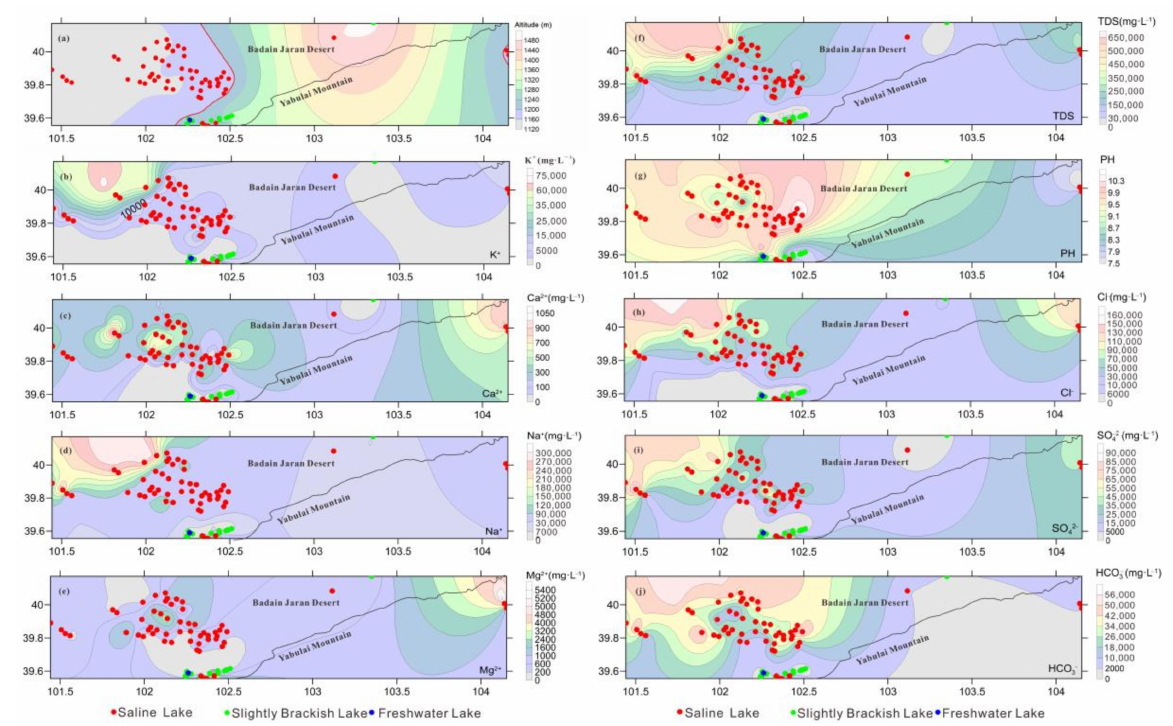
Figure 7. The spatial distribution of ion contents in the lakes of the Badain Jaran